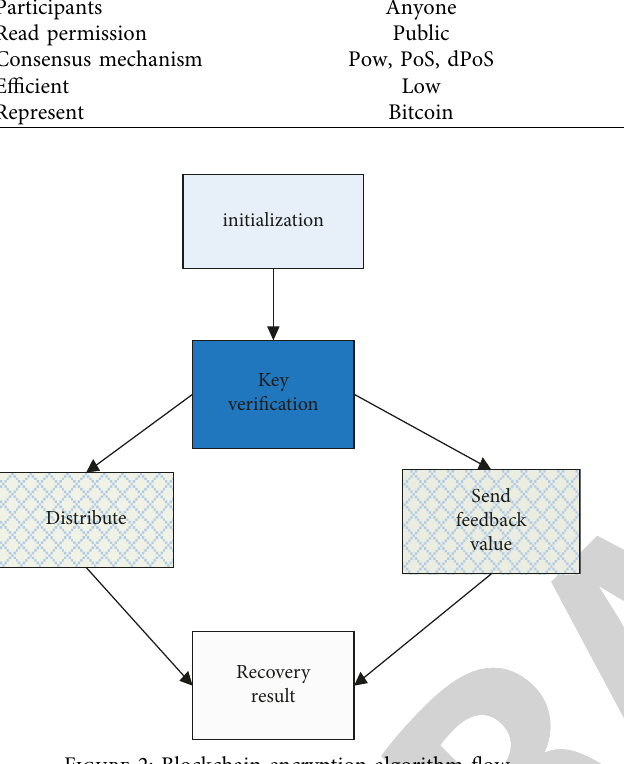
Figure 2: Blockchain encryption algorithm flow.